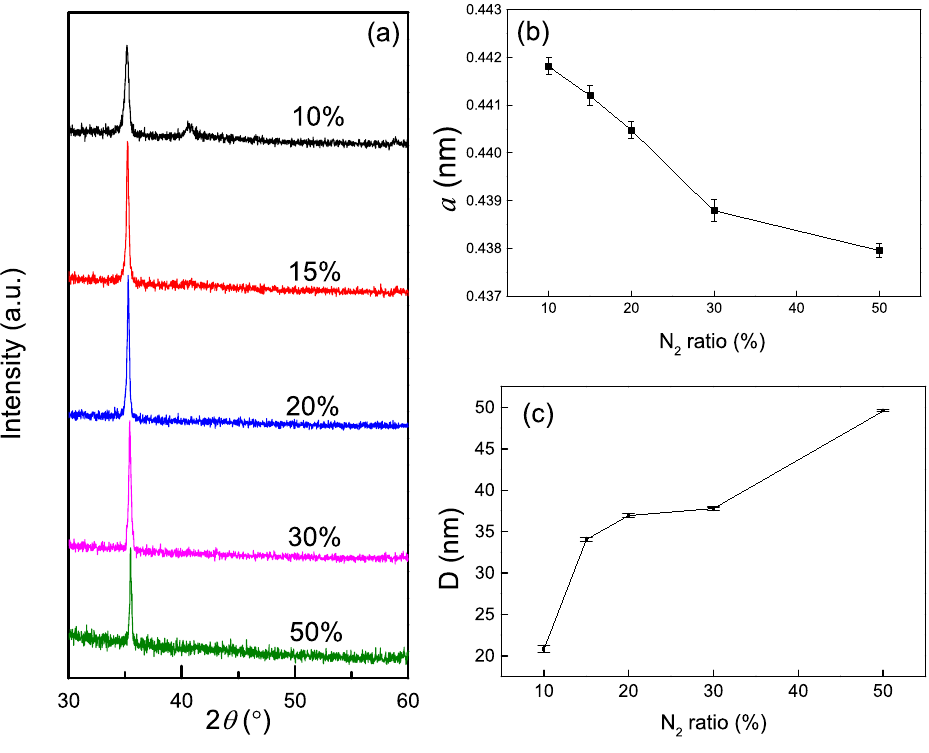
Figure 1. XRD θ -2 θ patterns ( a ), lattice constant ( b ), and crystallite size ( c ) of the (Ti, Zr)N x films deposited with different R n